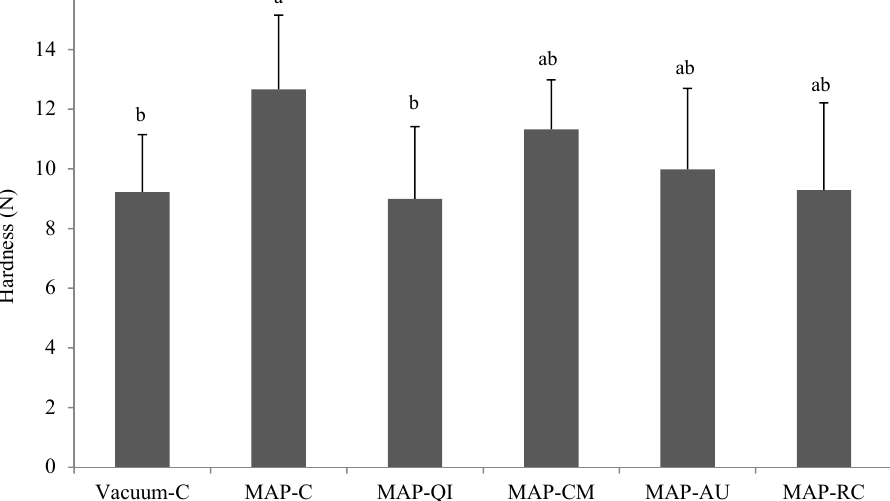
Figure 3. Instrumental hardness (N) of cooked lamb cutlets (mean ± standard deviation). Sample